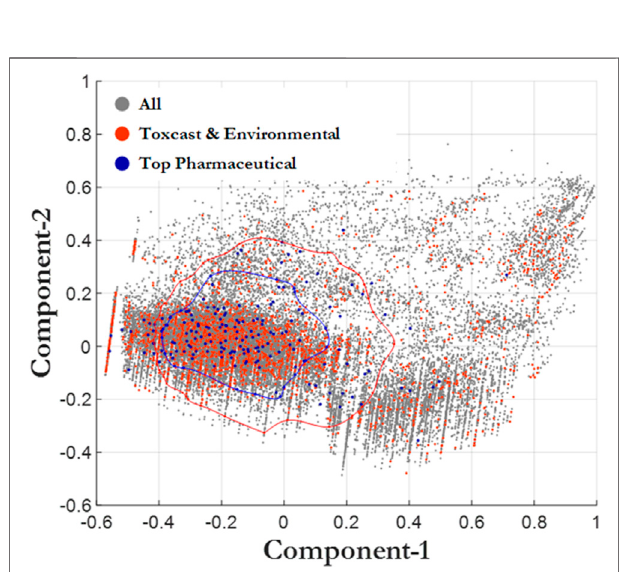
FIGURE 3 | Principal component analysis. All chemicals (CERAPP, gray), environmental chemicals from ToxCast (red), and top prescribed drugs (blue). The blue bubble surrounds the Top Pharmaceutical compounds that are one standard deviation away from the mean. The red bubble surrounds the ToxCast and Environmental compounds that are one standard deviation away from the mean.